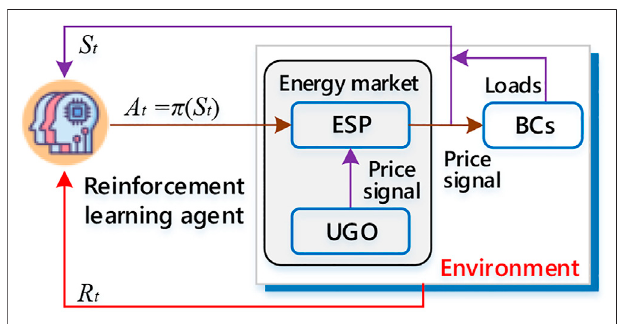
FIGURE 3 | Framework of the MDP dynamic pricing